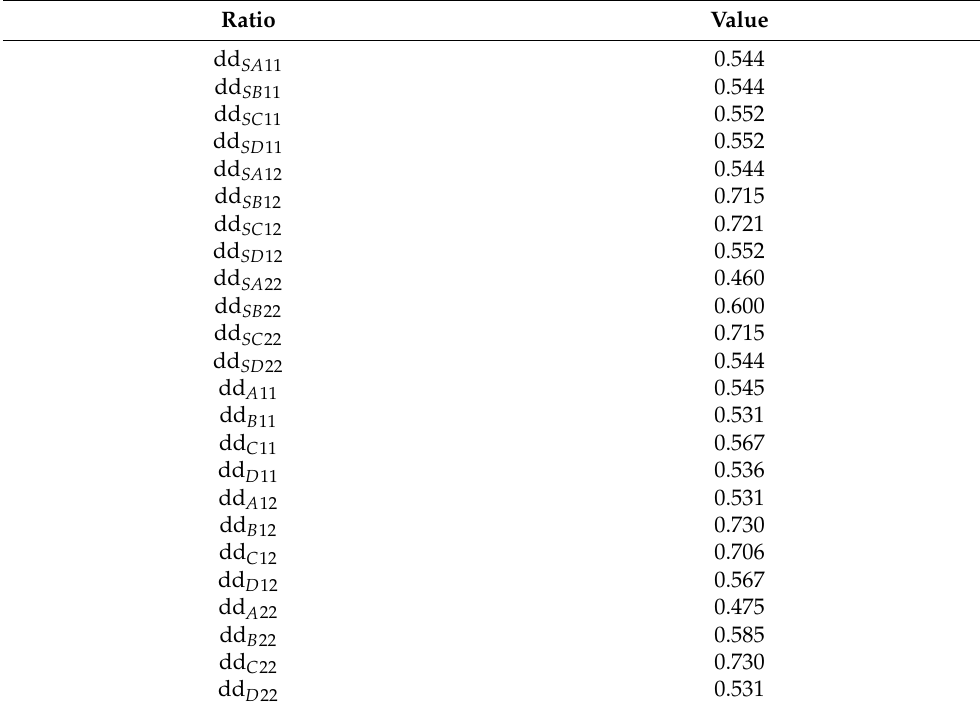
Table A8. The initial division coefficients defining the positions of the points S Aij , S Bij , S Cij , S Dij and the B v ’s vertices of the third structure Σ 3 for i , j = 1, 2.